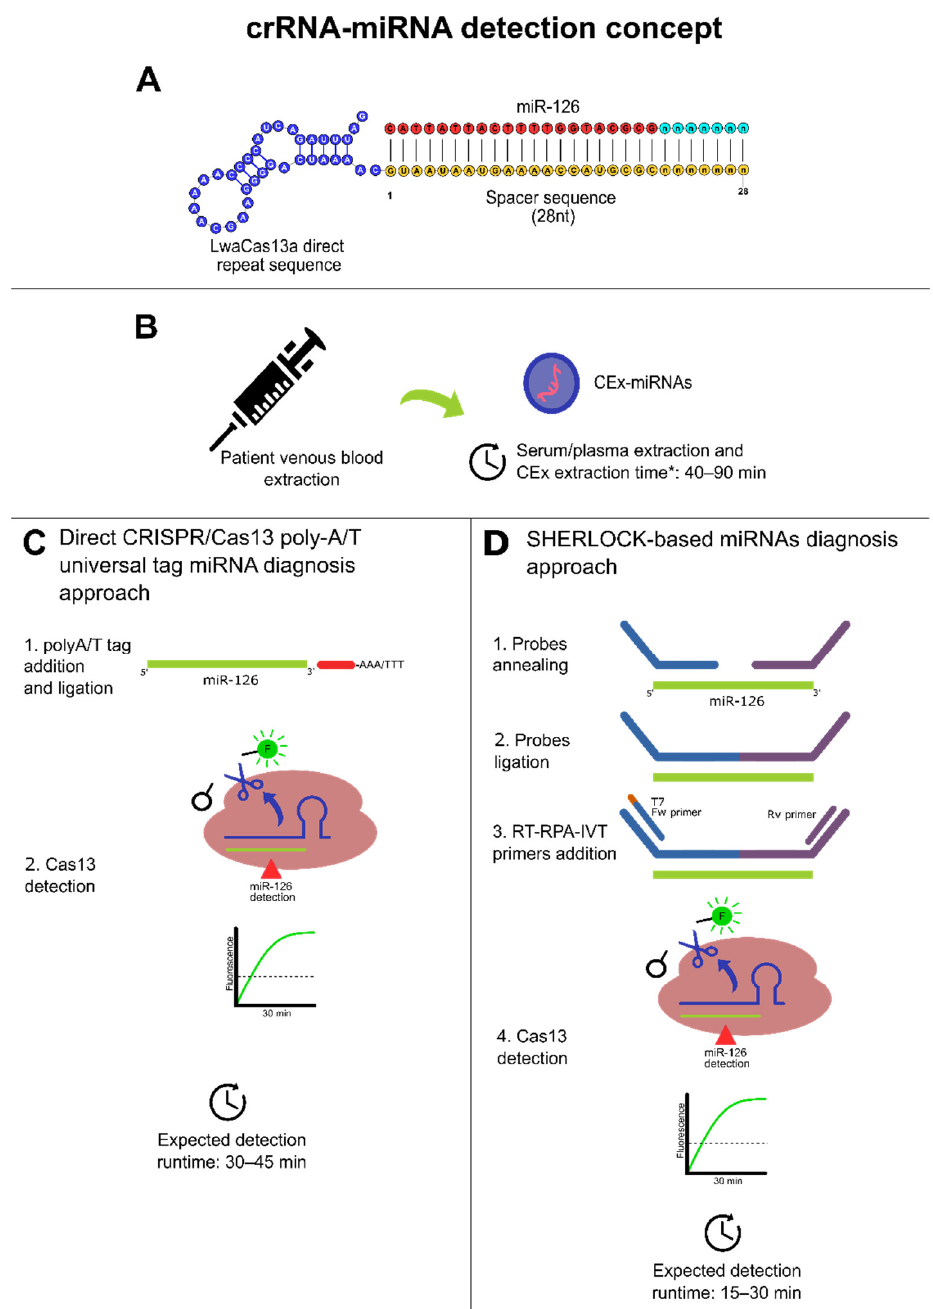
Figure 4. Dedicated CRISPR/Cas13-based miRNA diagnosis approaches. * Additional 30 min were added to consider miRNA extraction from exosomes. ( A ) Conceptual crRNA (direct repeat blue; spacer region: yellow; protospacer: red and cyan). ( B ) Obtention of peripheral blood from patients and CEx-miRNAs timeframe conceptualization based on [202]. ( C ) Direct CRISPR/Cas13 direct approach detection for diagnosis using a poly-A/T universal tag for CEx-miRNAs with a theoretical 2-steps method based on [178]. This approach may be suitable for highly abundant CEx-miRNAs targets. ( D ) A SHERLOCK-based diagnosis approach with a theoretical 4-steps method based on [22]. This approach may be suitable for high/low abundant CEx-miRNAs targets. For both cases ( C , D ), runtimes do not consider sample isolation and purification. Moreover, polyA/T ligation may need high